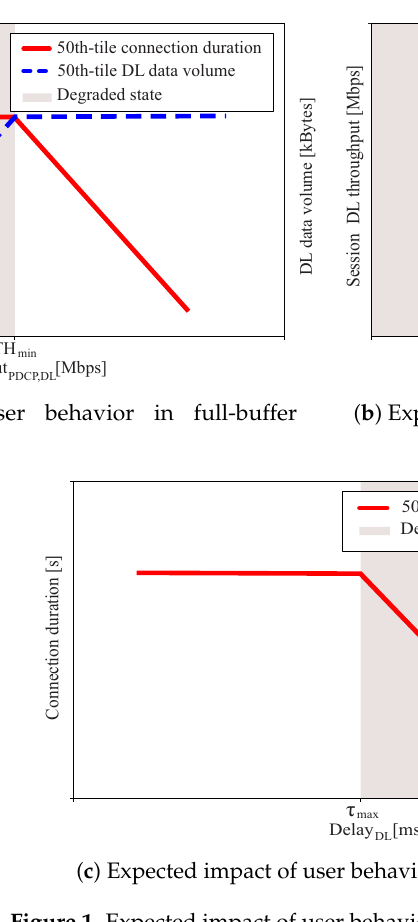
Figure 1. Expected impact of user behavior for broad service